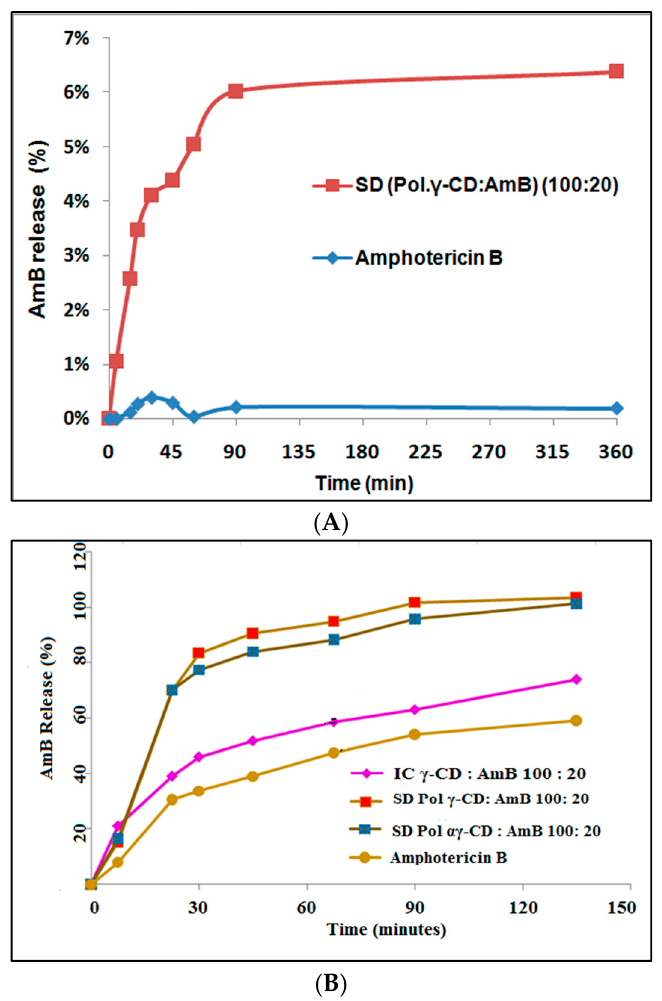
Figure 9. Dissolution profiles of AmB, solid dispersions (SD) with different polymers composition ( αγ -poly CD, γ -poly CD) and inclusion complex (IC) in simulated fluid medium pH = 7.4 with 0.02% ( A ) or 0.1% SLS ( B ).